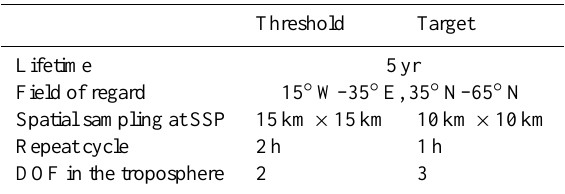
Table 1. Selected phase 0 threshold and target technical specifica- tions of MAGEAQ-TIR (adapted from Peuch et al., 2010). In the table, SSP: subsatellite